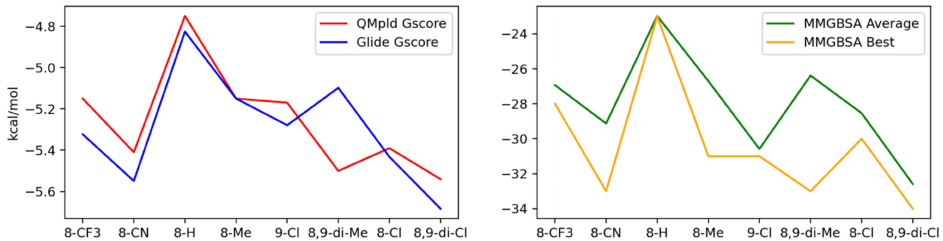
Figure 4. (Left) Best QM-pld G-Score and Glide XP G-Score. (Right) Best and average MMGBSA dG binding free energy.